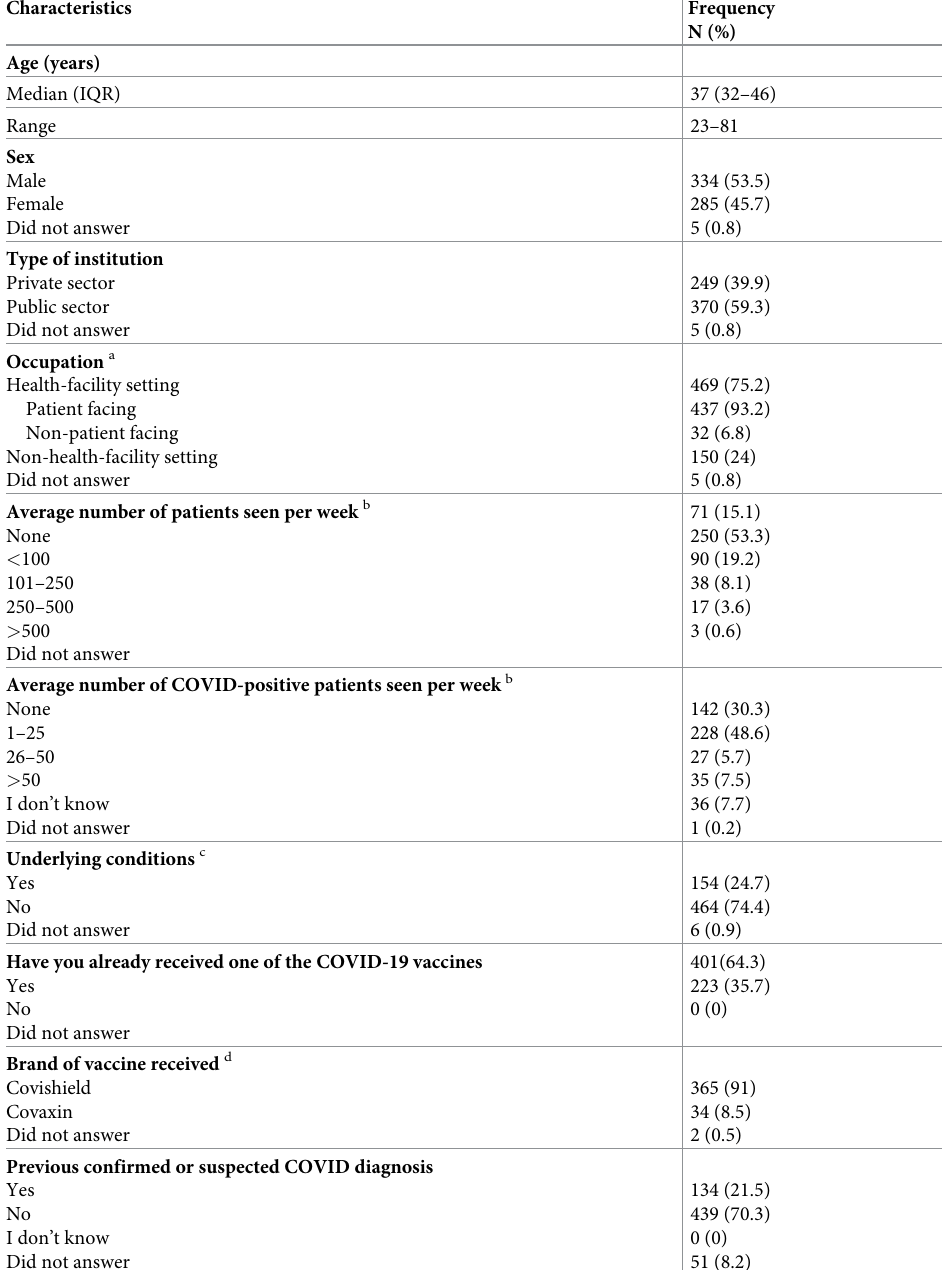
Table 1. Respondent demographics (n =